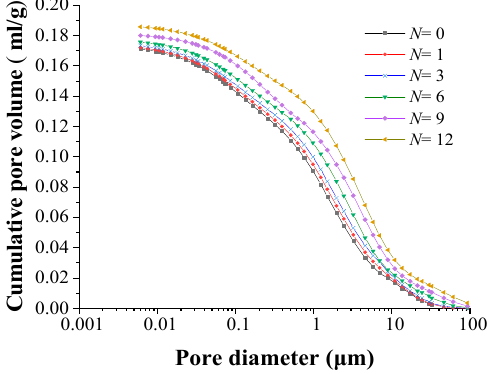
Figure 9. Curve of cumulative pore volume.